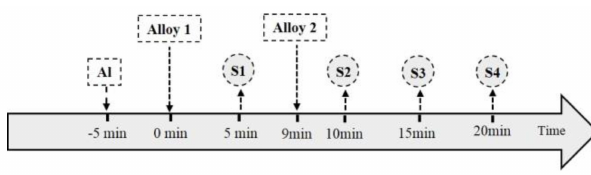
Figure 2. Addition of alloys and sampling procedure in the current experiments.